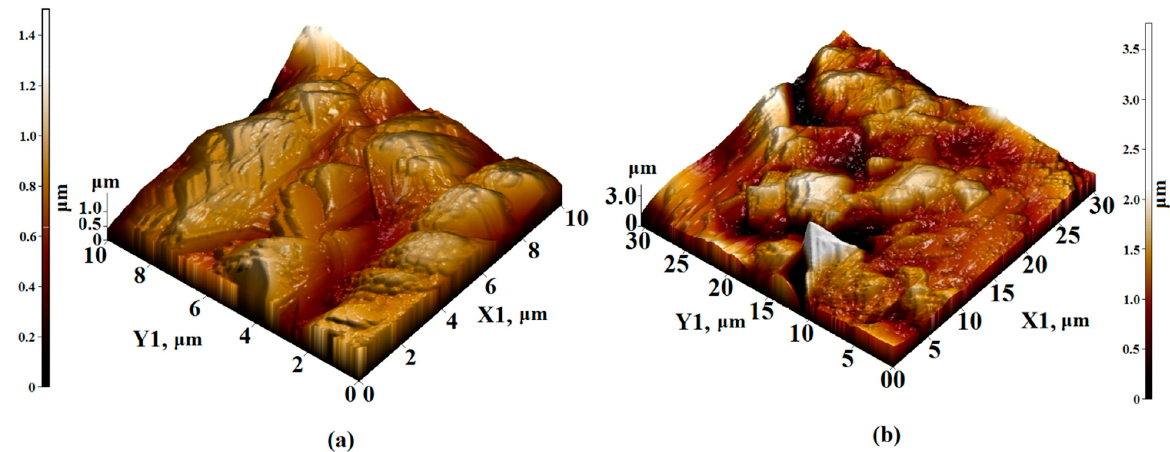
Figure 6. AFM 3D—image of the surface topology of ( a ) 10 × 10 µ m 2 and ( b ) 30 × 30 µ m 2 sections of the Sm 3 Fe 5 O 12 film formed on an Al 2 O 3 substrate.